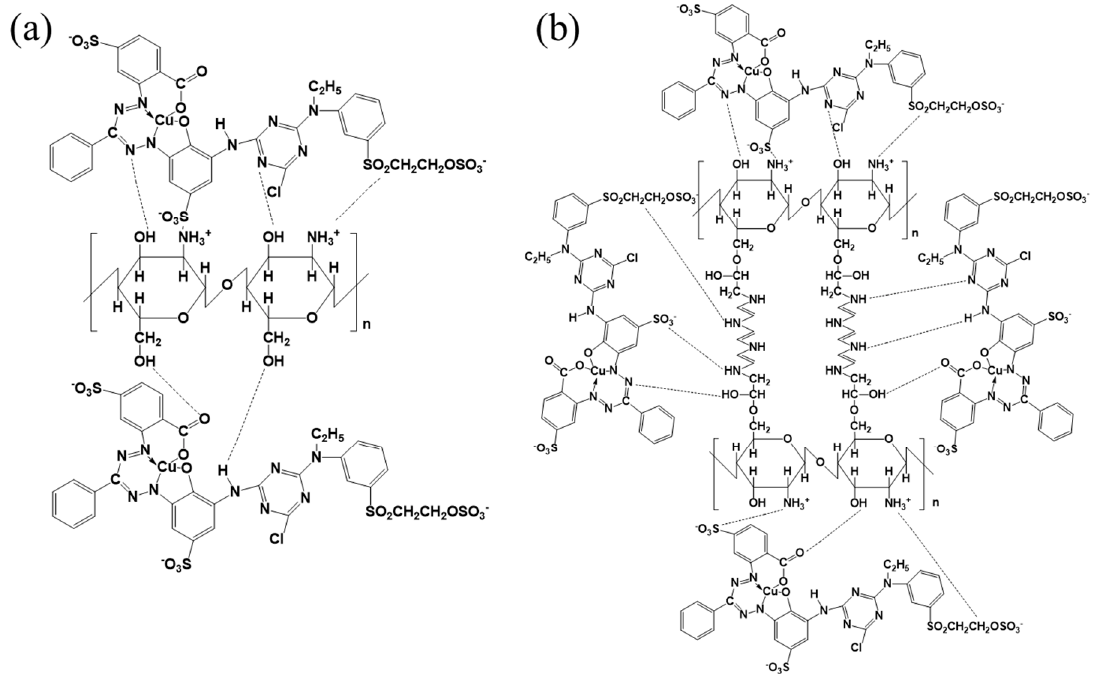
Figure 10. Mechanism of the RB221 adsorption by the adsorbents: ( a ) chitosan adsorbing the RB221 dye; and ( b ) BCCT adsorbing the RB221 dye.